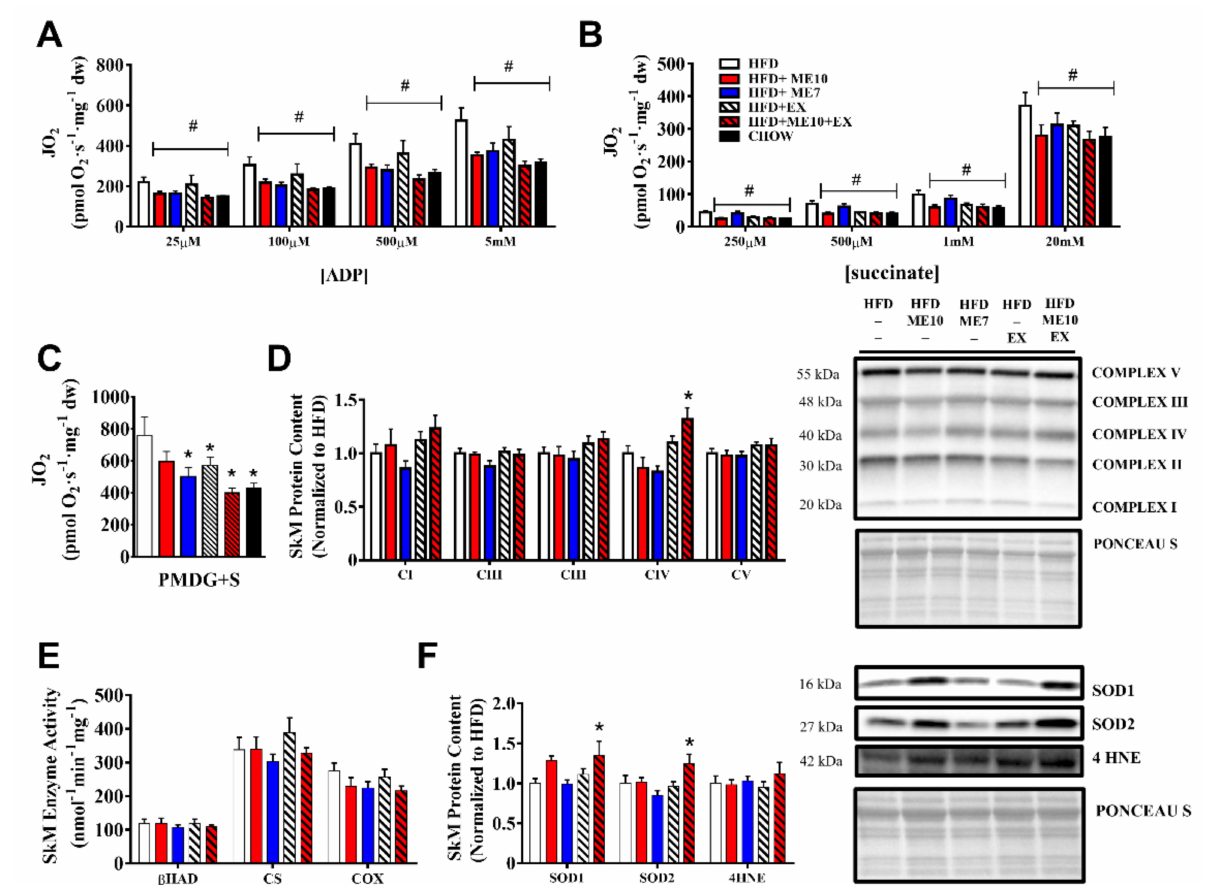
Figure 4. Alteration of mitochondrial bioenergetics and protein content following metabolic enhancer (ME) supplementation and/or exercise in skeletal muscle. Complex I-supported ADP-stimulated respiratory kinetics ( A ) were examined via the titration of submaximal ADP (25, 100, and 500 µ M) and maximal ADP (5 mM) in the presence of 5 mM pyruvate and 2 mM malate. #: main effect across all [ADP] titrations, HFD compared to all other experimental groups ( p < 0.05). Complex II-supported respiration ( B ) was determined through the stepwise addition of succinate (FADH 2 ) in the presence of 5 mM ADP and 10 µ M rotenone (to inhibit and prevent superoxide generation at complex I). Titration experiments examined via 2-way ANOVA. ( C ) Maximal ADP-stimulated respiration in the presence of complex I- and II-linked substrates, PMDG + S, pyruvate (P), malate (M), ADP (D), glutamate (G) + succinate (S). 1-way ANOVA with Fisher’s LSD post-hoc test. *: p < 0.05 compared to the high-fat diet (HFD) group. Protein content ( D ) of OXPHOS complexes (Complex I–V) in SkM tissue, expressed relative to the HFD group with representative blots. 1-way ANOVA with Fisher’s LSD post-hoc test. *: p < 0.05 compared to the high-fat diet (HFD) group. Maximal enzyme activity of ( E ) β -HAD, COX, and CS in skeletal muscle ( p > 0.05). Protein content ( F ) of antioxidant SOD1 and SOD2, and marker of lipid peroxidation 4-Hydroxynonenal (4-HNE) with representative blots. 1-way ANOVA with Fisher’s LSD post-hoc test. *: p < 0.05 compared to the high-fat diet (HFD) group. Data are represented as the mean ± SEM ( n = 8–12 per